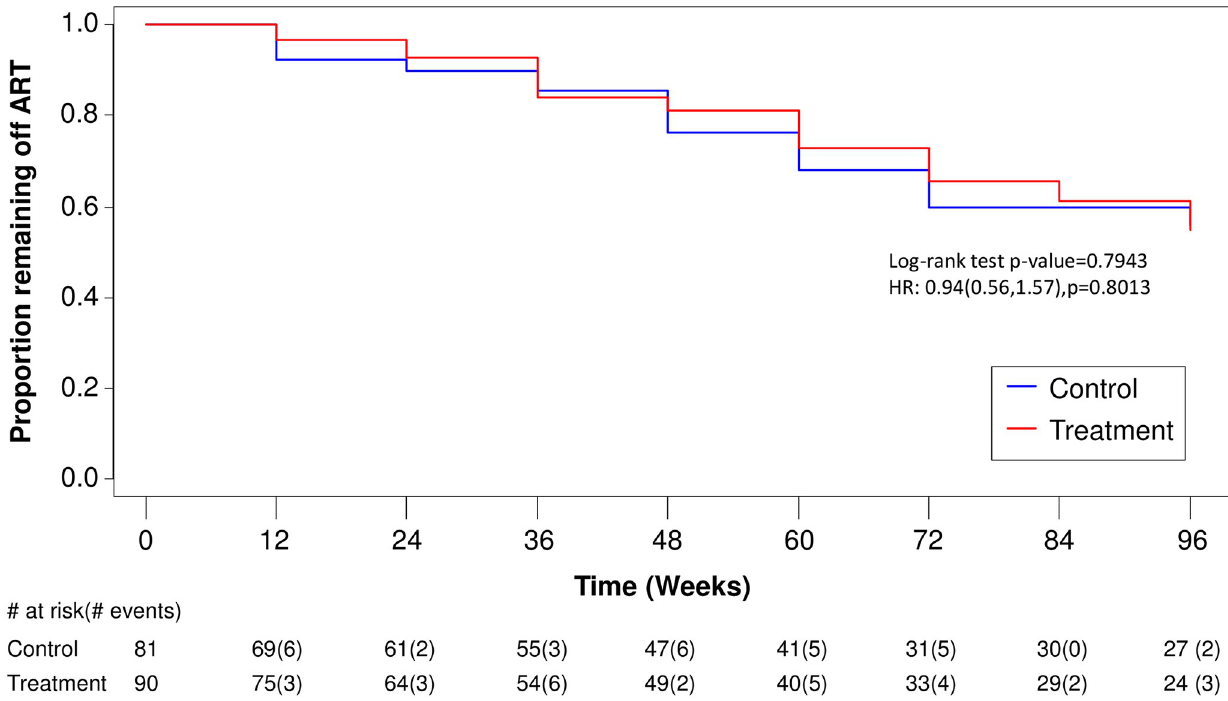
Fig 3. Kaplan-Meier Curve: Time to start of ART regardless of CD4 T lymphocyte count. Week 0 includes all individuals who were screened in and allocated to a group. The table beneath shows the individuals remaining at risk at each time point and the number of individuals remaining at risk at each time point and the number of individuals experiencing an event in that interval is in brackets. There were 29 events in the Control group and 28 events in the Treatment group over the study period of 96 weeks.